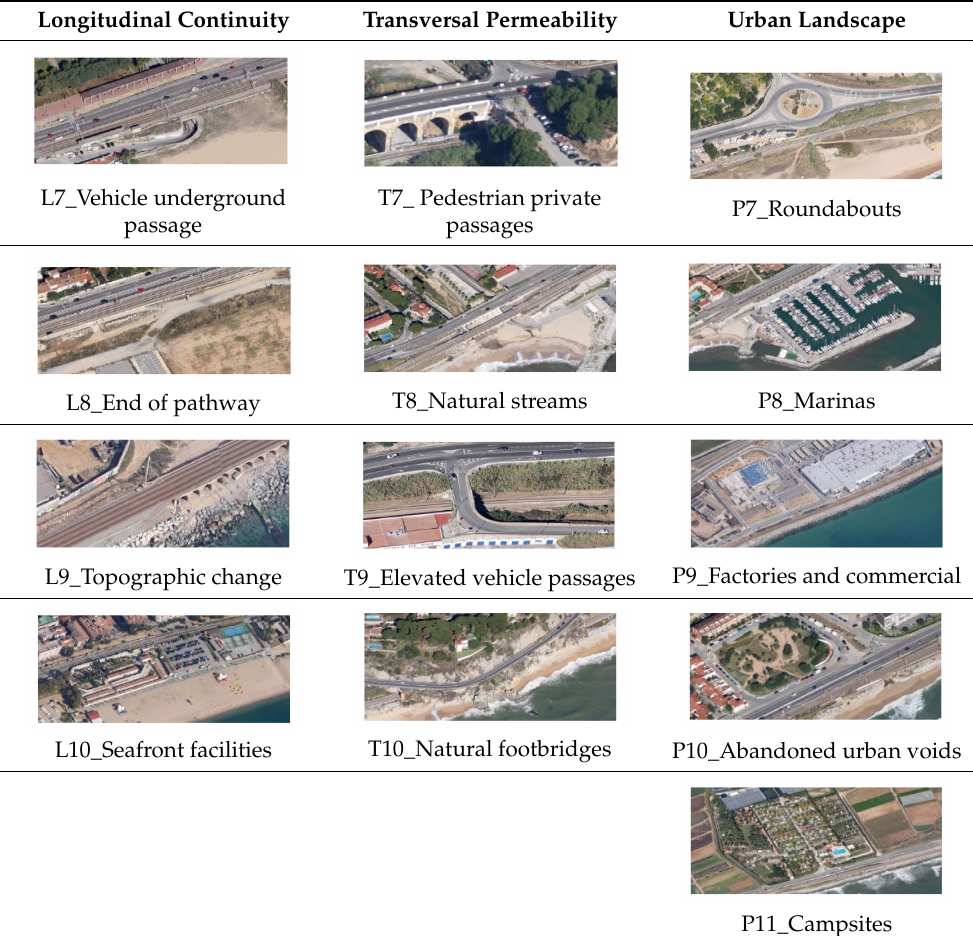
Table 2. Cont . Longitudinal